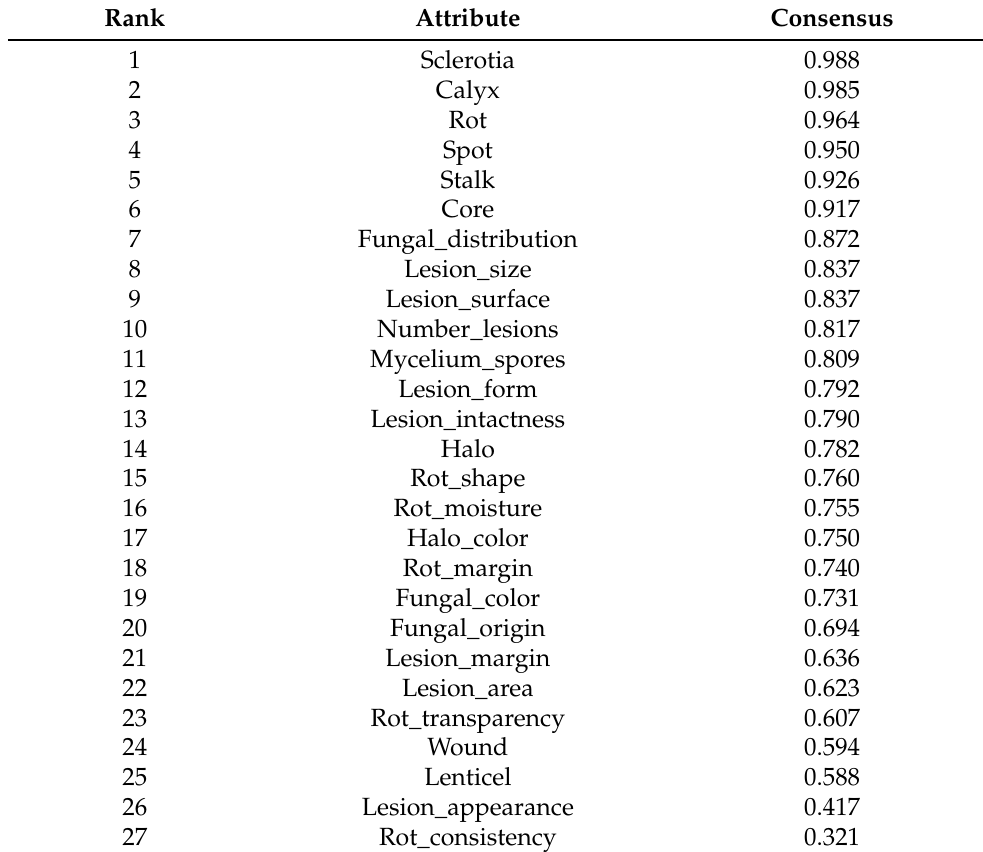
Table 4. Attributes ranking based on the consensus of users in the MUS with the domain expert of